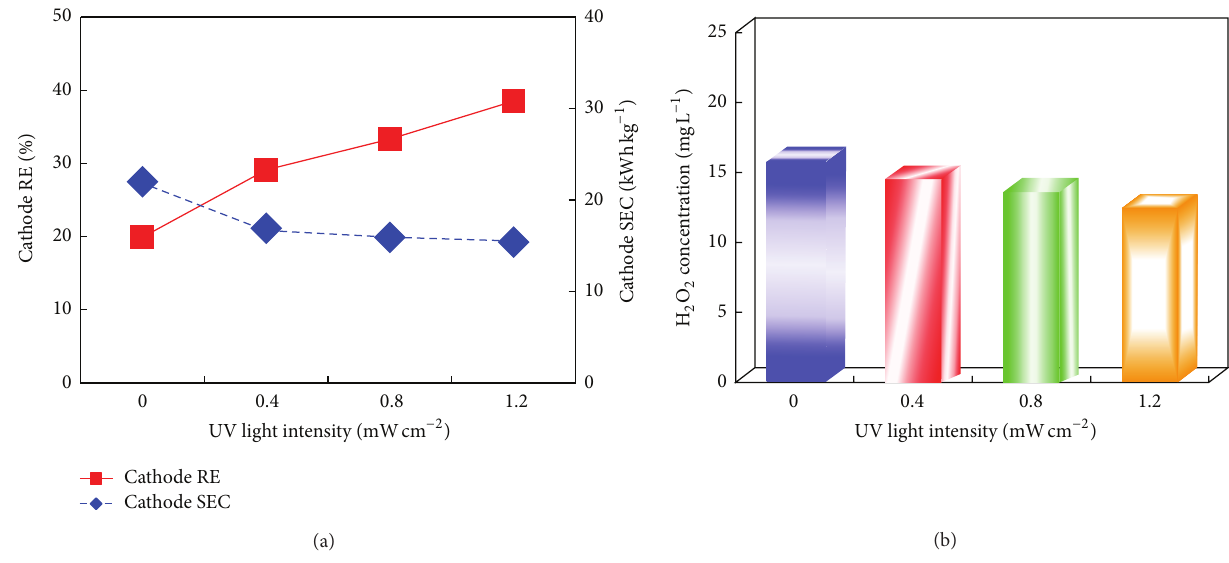
Figure 6: Effect of UV-light intensity: (a) removal efficiency and SEC of PVA and (b) concentration of H 2 O 2 generation with different UV- light intensity in the cathodic compartment (current density = 3mAcm −2 , temperature = 323 K, anodic compartment: PVA = 50 mgL −1 , Ce(III) = 0.01 M, HNO 3 = 0.3 M; cathodic compartment: PVA = 50 mgL −1 , Na 2 SO 4 = 0.05 M, pH = 3, and oxygen flow rate = 500 cm 3 min −1